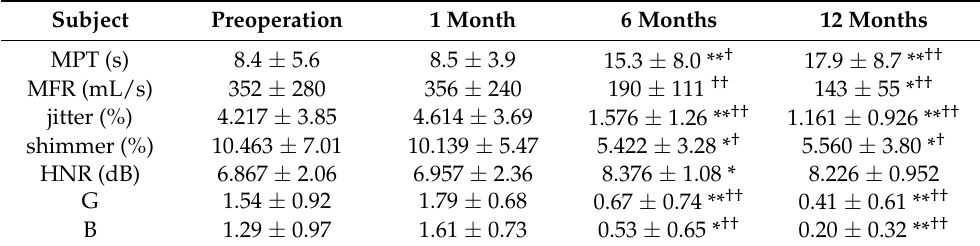
Table 2. The average values of each parameters in paralyzed-reconstruction subgroup.